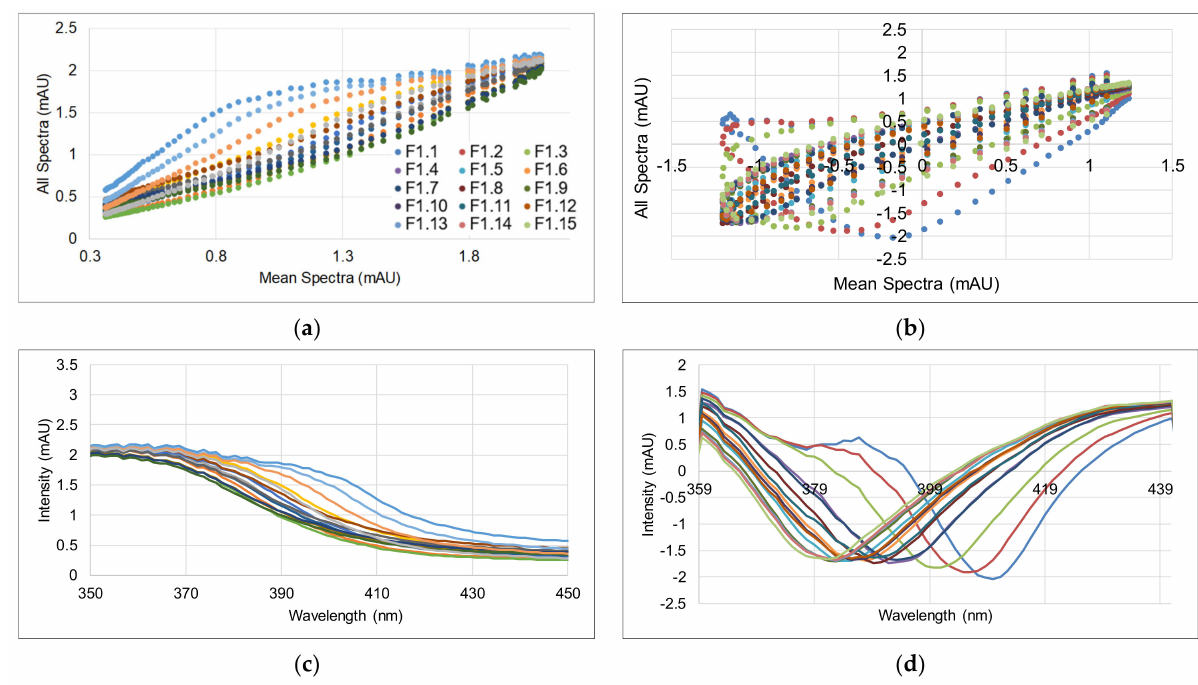
Figure 8. ( a ) Scatter effects of DAD spectra before and ( b ) after preprocessing; ( c ) data of DAD spectra before and ( d ) after preprocessing, legend from ( a ) applies for all figures.